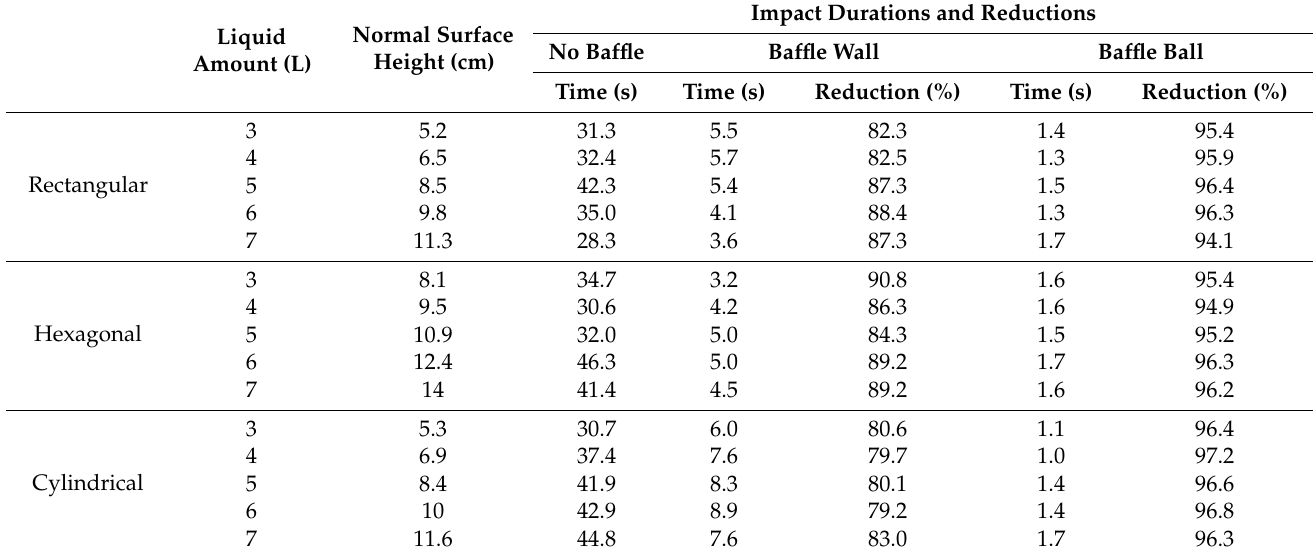
Table 2. Liquid-slosh impact times for the different liquid amounts in different